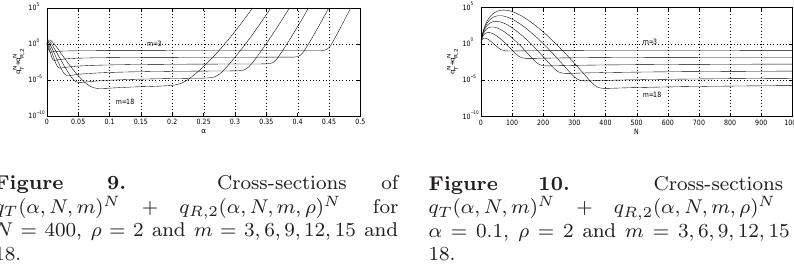
Figure 9. Cross-sections of q T ( α,N,m ) N + q R, 2 ( α,N,m,ρ ) N for N = 400 , ρ = 2 and m = 3 , 6 , 9 , 12 , 15 and 18 .